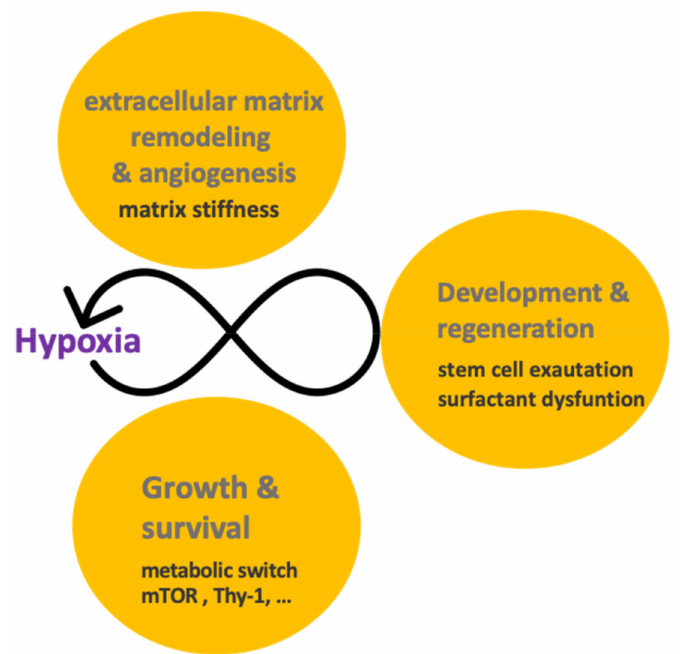
Figure 3. Persistent hypoxia activation. In cancer and fibrosis, hypoxia is a key participant in several processes that have feedback loops, especially when these processes have dysfunctions that promote hypoxia perpetuation (in